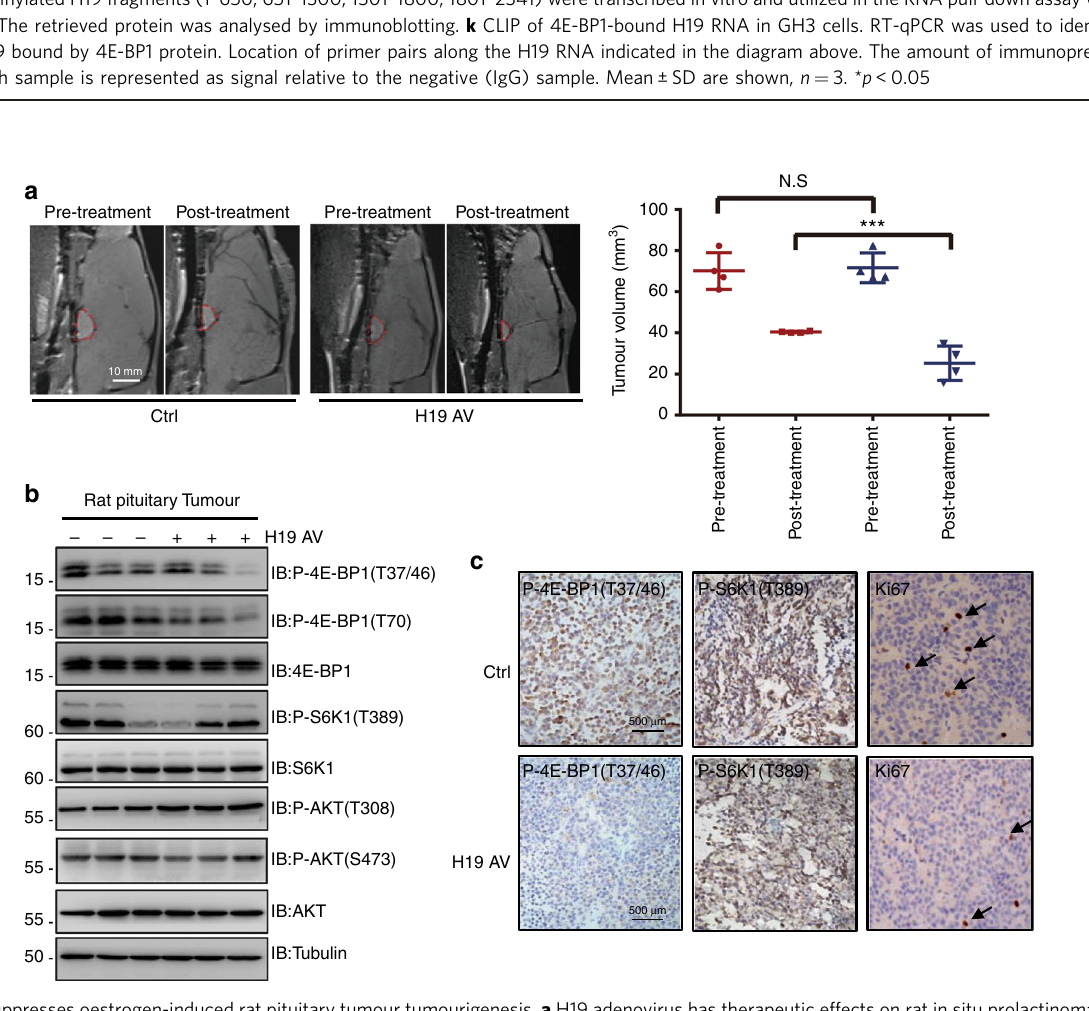
Fig. 5 H19 represses 4E-BP1 binding to Raptor by masking the 4E-BP1 TOS motif. a – c Immunoblot analysis of whole-cell lysates and immunoprecipitates derived from GH3 cells transfected with the indicated constructs. The RNase treatment group was used as the negative control. d H19 overexpression